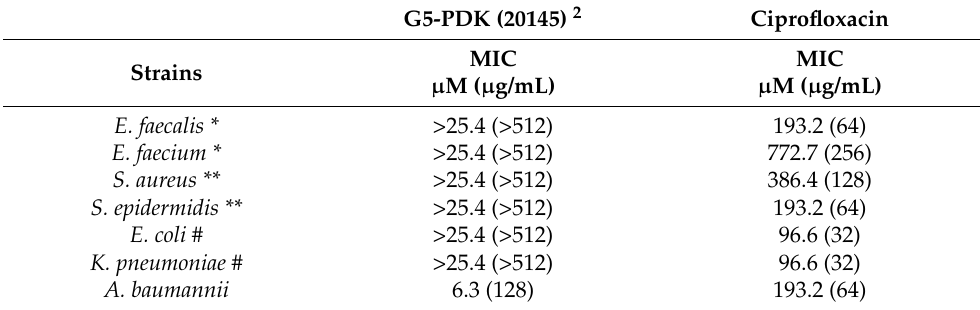
Table 3. MIC values of G5-PDK on relevant representatives of Gram-positive and Gram-negative bacteria obtained from experiments carried out in triplicate 1 , expressed as µ M and as µ